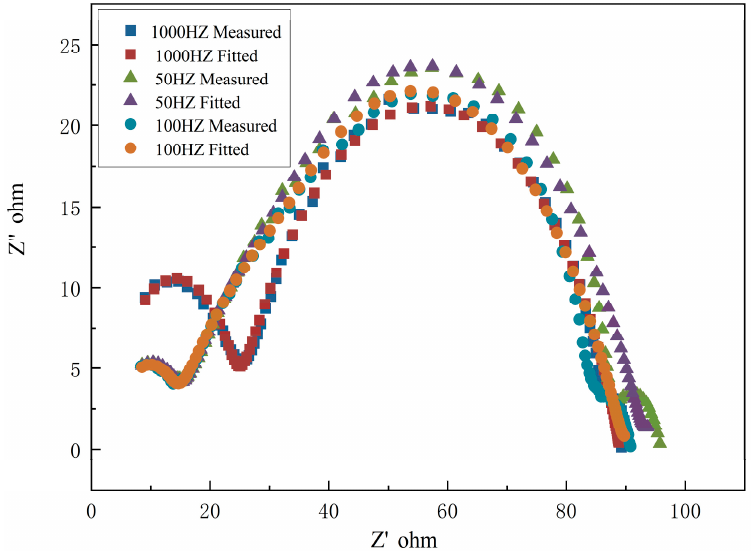
Figure 9. Degradation rates of electrodeposited zinc for 30, 60, and 120 days.